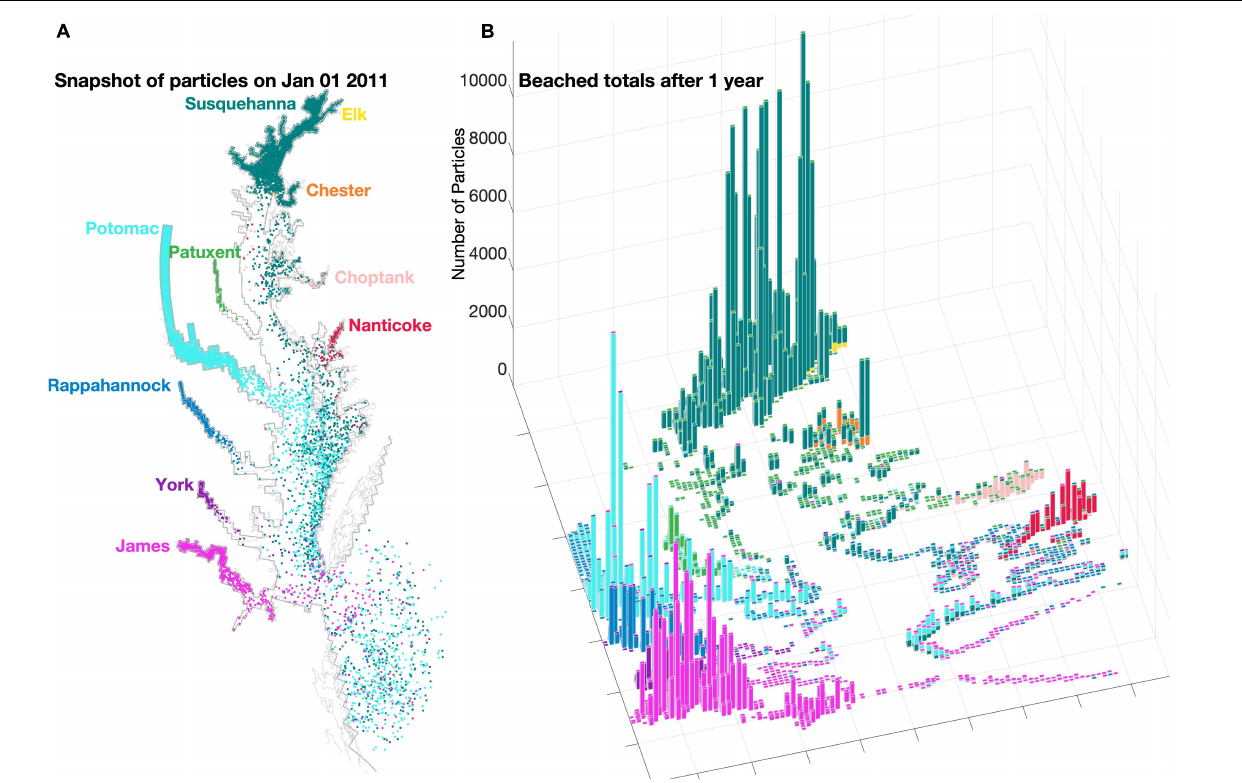
FIGURE 3 | Simulated locations of sinking and floating particles (color-coded by river) after 1 year in (A) the water column and (B) on the shoreline (i.e., beached). An animation of the full simulation exists as Supplementary Video 1